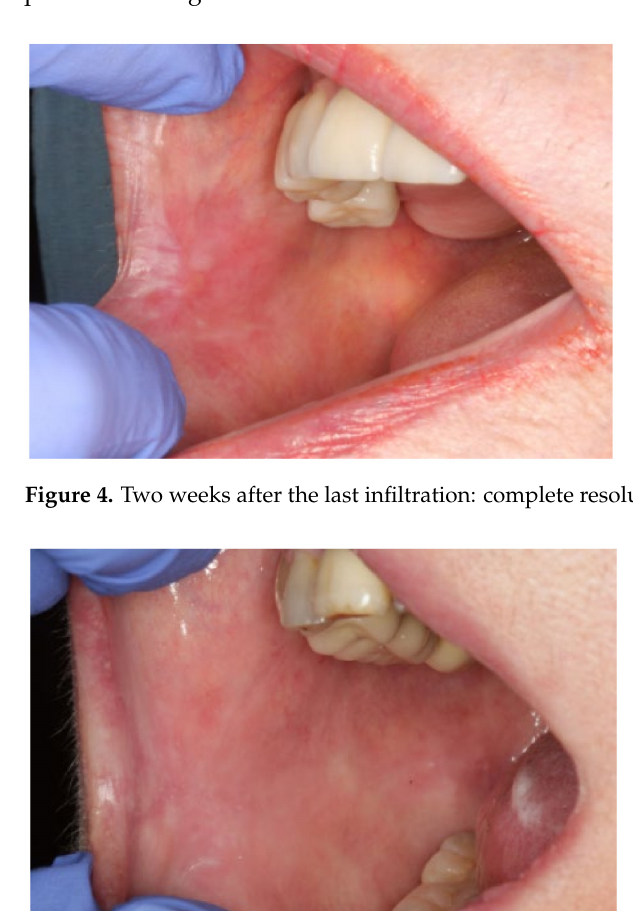
treatment (prednisone 5 mg/day PO). (Figure 5). A timeline and outcomes summary are presented in Figure 6.